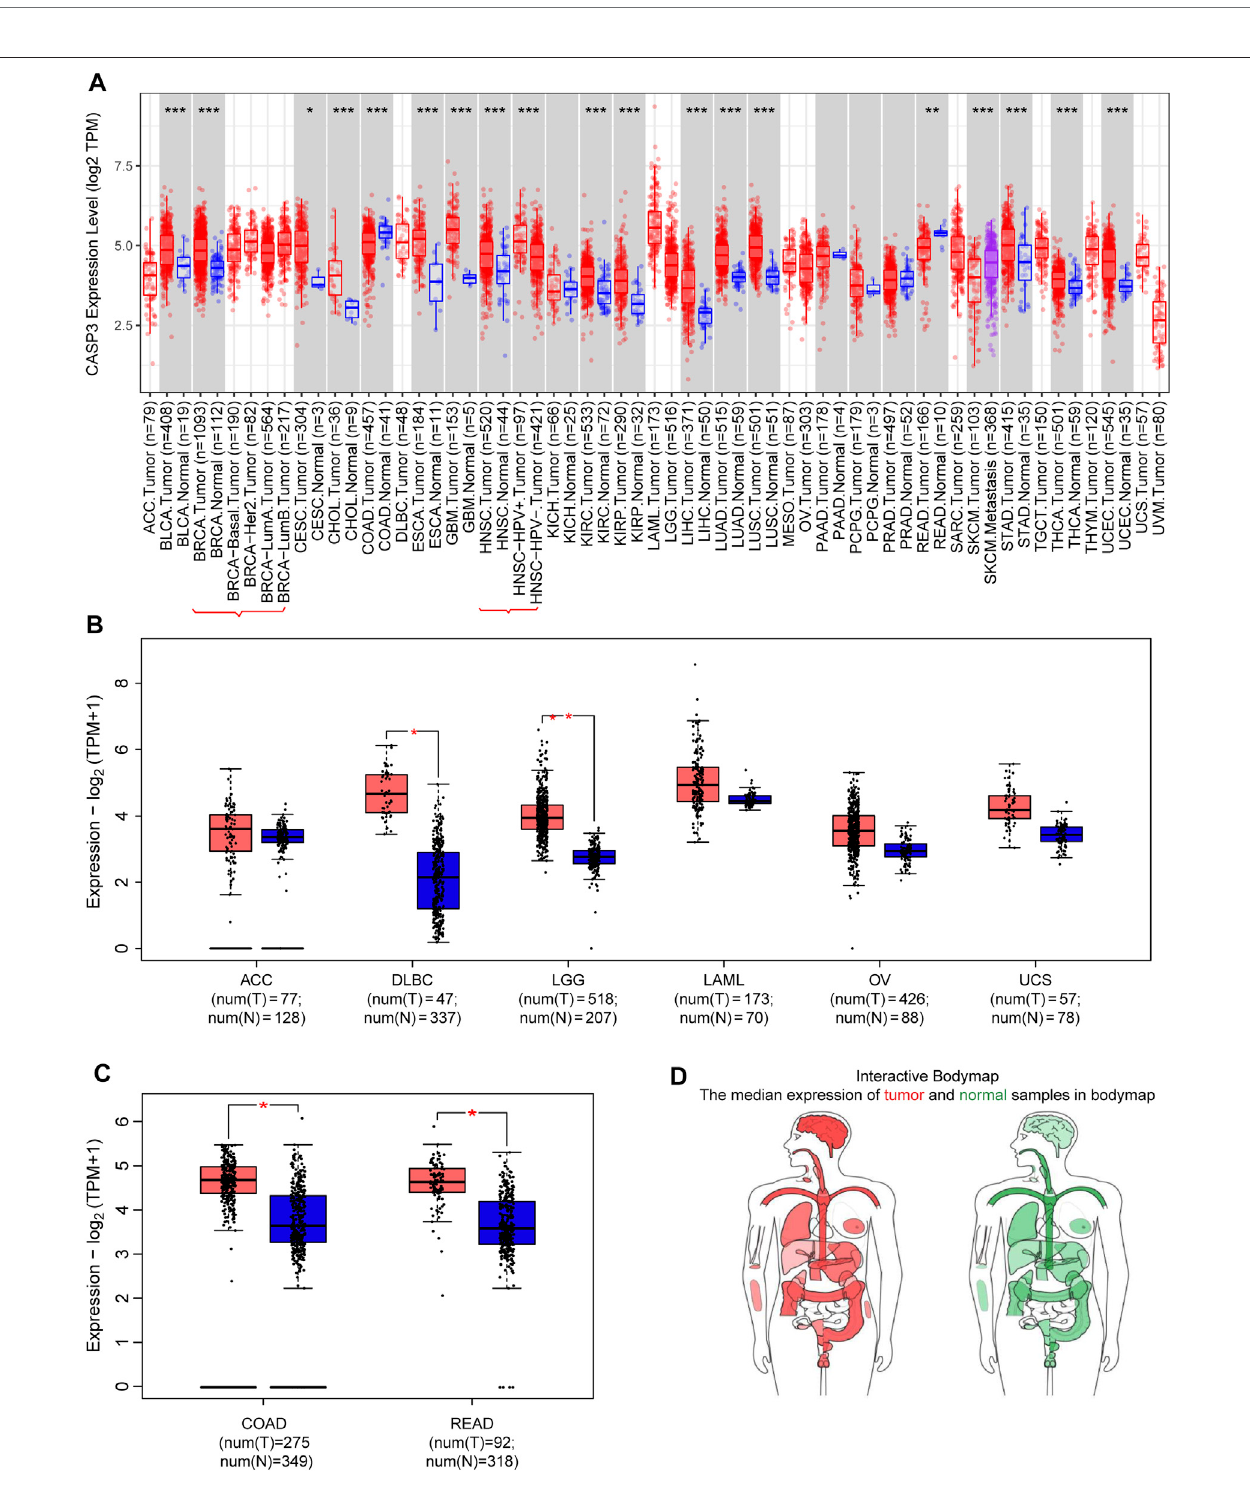
FIGURE 1 | Expression of CASP3 gene in different tumours. (A) Analysis of the expression of CASP3 in different tumours or speci fi c cancer subtypes by TIMER2. * p < 0.05, ** p < 0.01, *** p < 0.001. (B,C) ForACC, DLBC, LGG, LAML,OV,uterine carcinosarcoma(UCS), COAD and READ in the TCGA database, thecorresponding normaltissuesintheGTExdatabase areusedascontrolsandprovided boxplotdata.* p < 0.05. (D) mapof CASP3 expression intumoursindifferentpartsofthehuman body by GEPIA2.